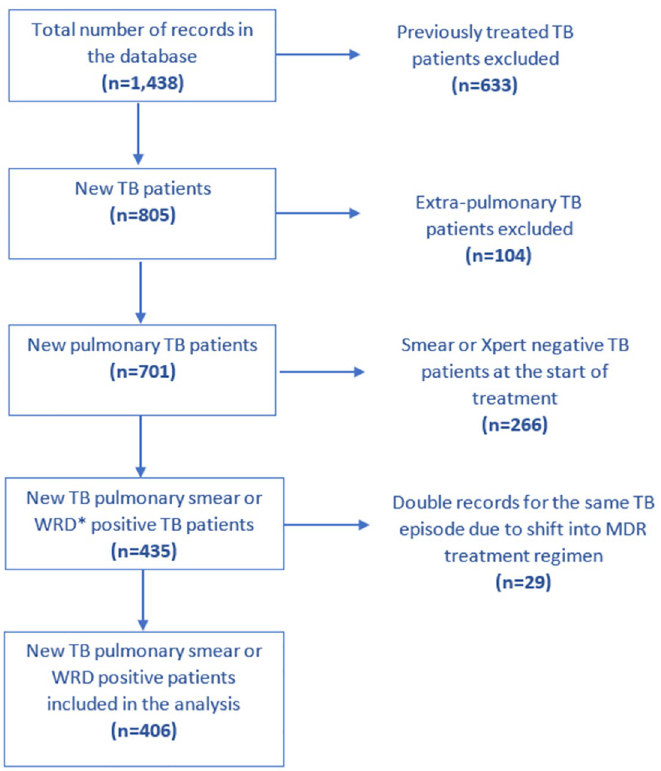
Fig 1. Flowchart of study population based on exclusion criteria. � WRD–WHO recommended rapid diagnostics.